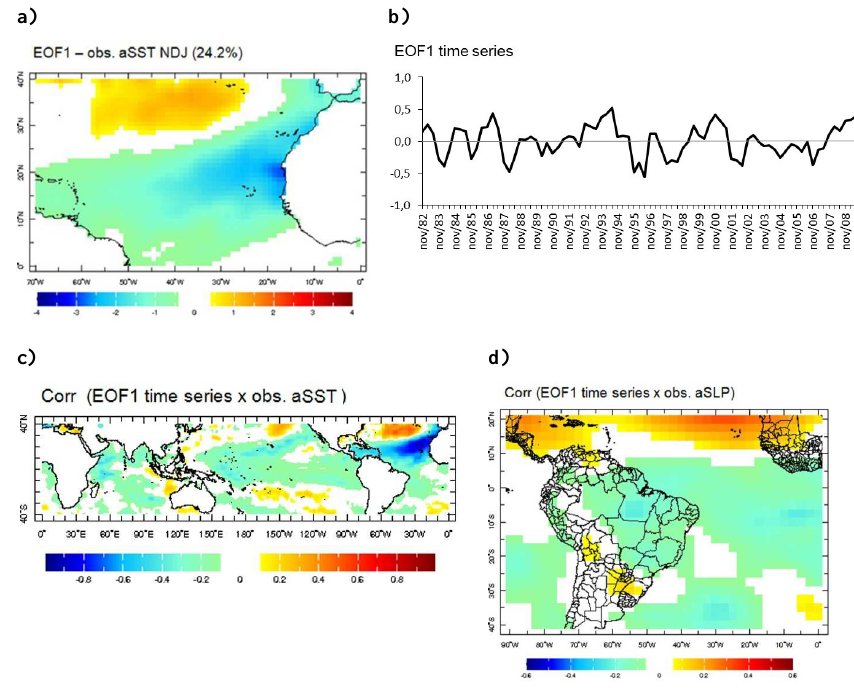
Figure 5. 1 Fig. 5. As in Fig. 4 but for the North Atlantic